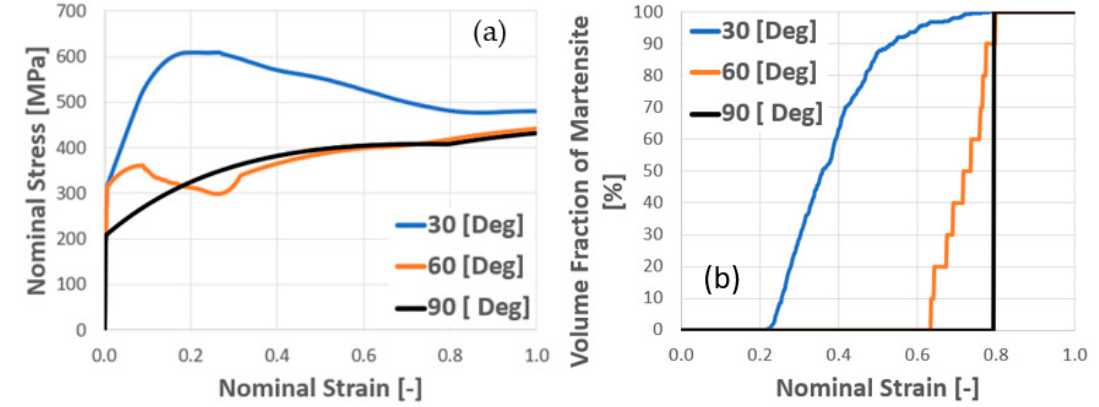
Figure 6. ( a ) Nominal stress versus nominal strain and ( b ) the volume fraction of martensite versus nominal strain under various initial crystallographic orientations.